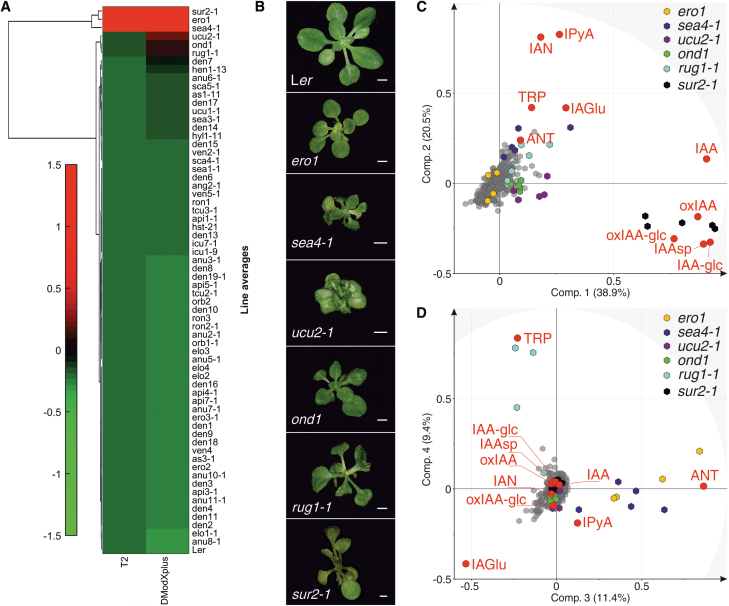
Identification of five mutant lines with markedly different IAA metabolic profiles. (A) Clustergram of average normalized Hotelling’s distance (T2) and distance to the model (DModXP+) values relative to the PCA model for the Ler wild-type IAA metabolite profile (for which values for all variables are zero). Euclidean distance was used for lines, linear correlation for variables (metabolites), and average linkage for both. Green and red indicate the degree of similarity to and difference from Ler, respectively. Values were calculated with SIMCA and the clustergram was constructed in MATLAB. (B) Rosette phenotypes of the Ler wild type and the five most different lines identified in the analysis, 20 d after stratification (das). The sur2-1 mutant was photographed on 16 das. Scale bars represent 1 mm. (C, D) PCA biplots showing separation of the samples (mutant lines, represented by hexagons) according to the variables (metabolites, represented by red dots). Points indicating lines with the highest degree of separation are coloured in yellow (ero1), dark blue (sea4-1), light blue (rug1-1), violet (ucu2-1), green (ond1), and black (sur2-1 control line). Points indicating the other lines, including the Ler wild type, are coloured grey. Biplots were constructed in SIMCA and correspond to (B) PC1 versus PC2 and (C) PC3 versus PC4, together explaining 80% of the total variation in the data.